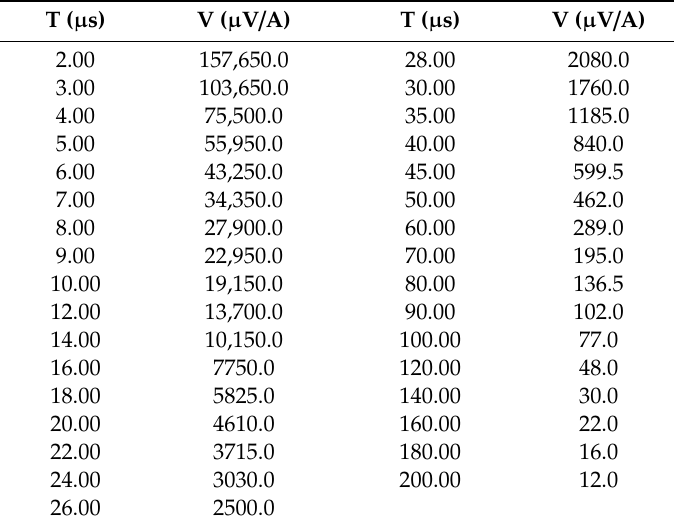
Table 1. Experimental transient electromagnetic (TEM) data.